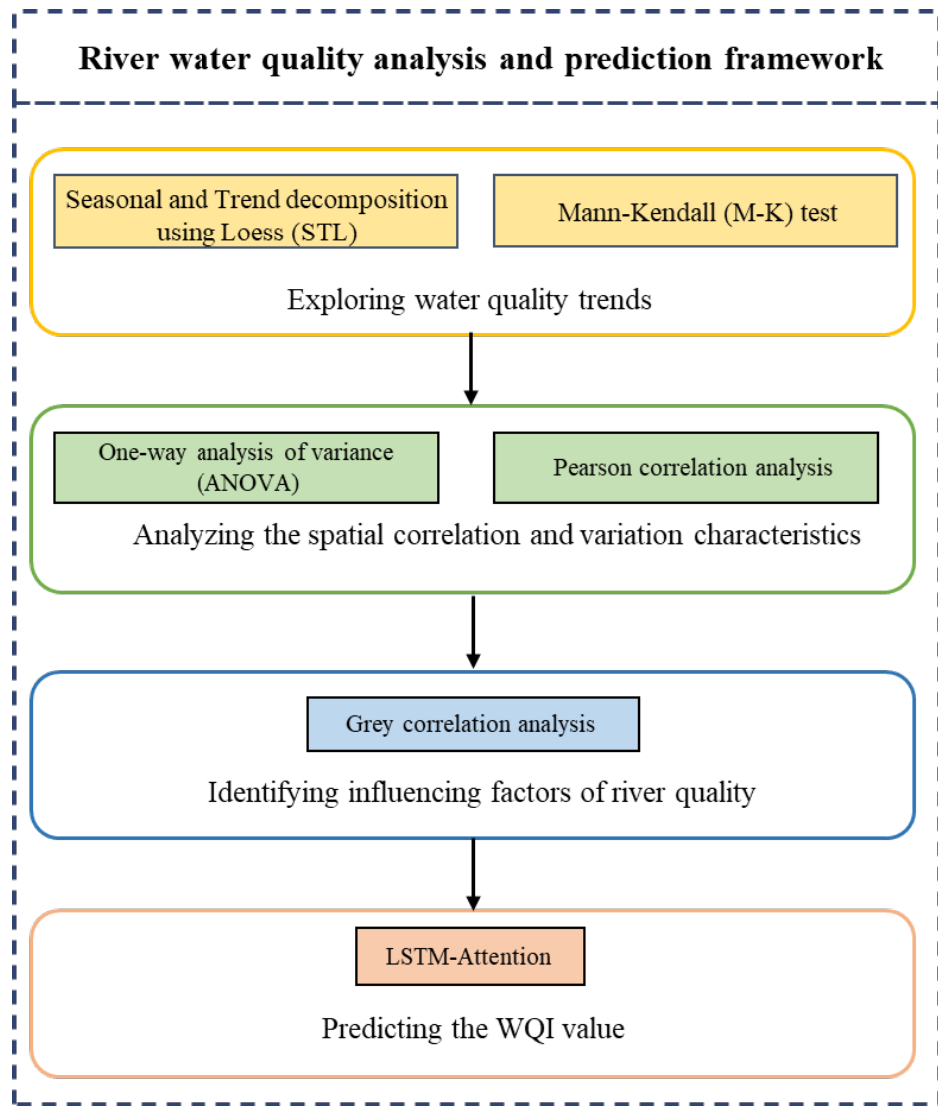
Figure 2. River water quality analysis and prediction framework.